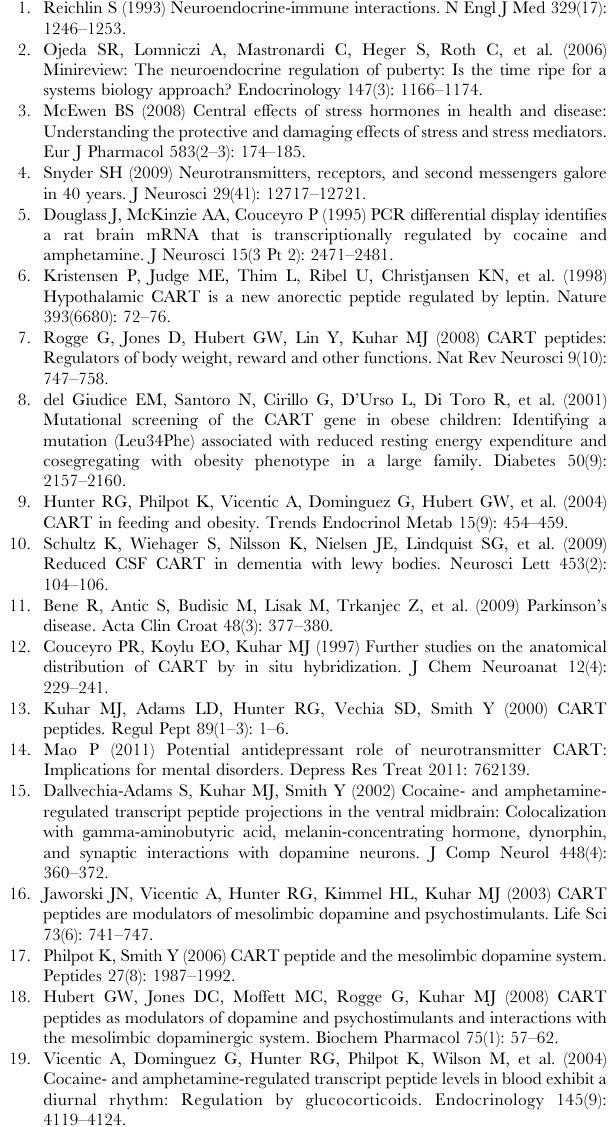
Figure S6 Confocal imaging of TAT-EGFP-CART in live cells shows CART fusion proteins preferentially local- ized into mitochondria comparing with TAT-EGFP control. Cultured HEK293 cells were treated overnight with 8 m g/ml of TAT-EGFP-CART or TAT-EGFP fusion proteins as indicated, and then treated with 50 nM of MitoTracker Red CMXRos for 30 min. Living cells were analyzed by a confocal microscopy. Top row, confocal fluorescence images depict cells treated with TAT-EGFP-CART fusion proteins; and bottom row, confocal fluorescence images depict cells treated with vehicle TAT-EGFP fusion proteins. Cells in panels A and D show GFP (green), cells in panels B and E show mitochondria (red), and panels C and F are merged images (yellow). Pixels containing fluorescence for both GFP and the red MitoTracker appear